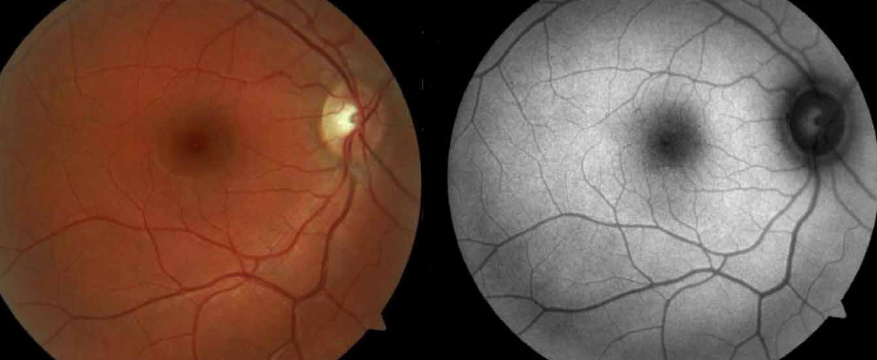
Figure 2 : Conventional fundus and fundus autofluorescence photograph of a normal eye. Note dark macula, blood vessels and disc. (Photograph courtesy of Dr Peter